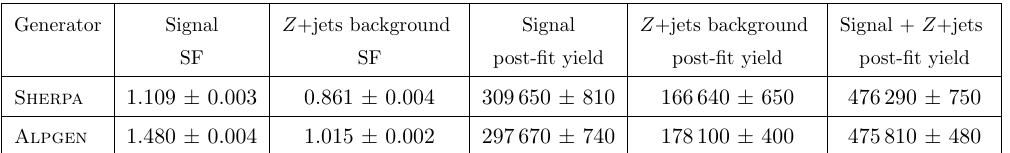
Table 4 . Scale factors obtained for the (cid:12)tted signal and Z +jet background for Sherpa and Alpgen (cid:12)ts, the total post-(cid:12)t yields, and the statistical uncertainty, estimated with pseudo-experiments, from the (cid:12)t for the 1-tag signal region.